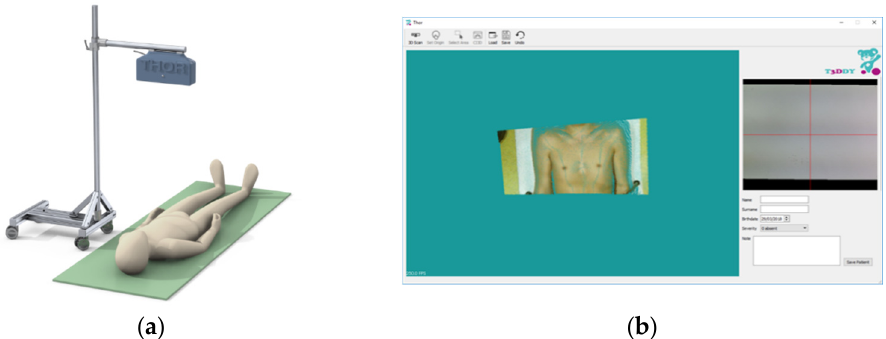
Figure 1. Previous version of the chest scanner: ( a ) hardware infrastructure; ( b ) graphical user interface.